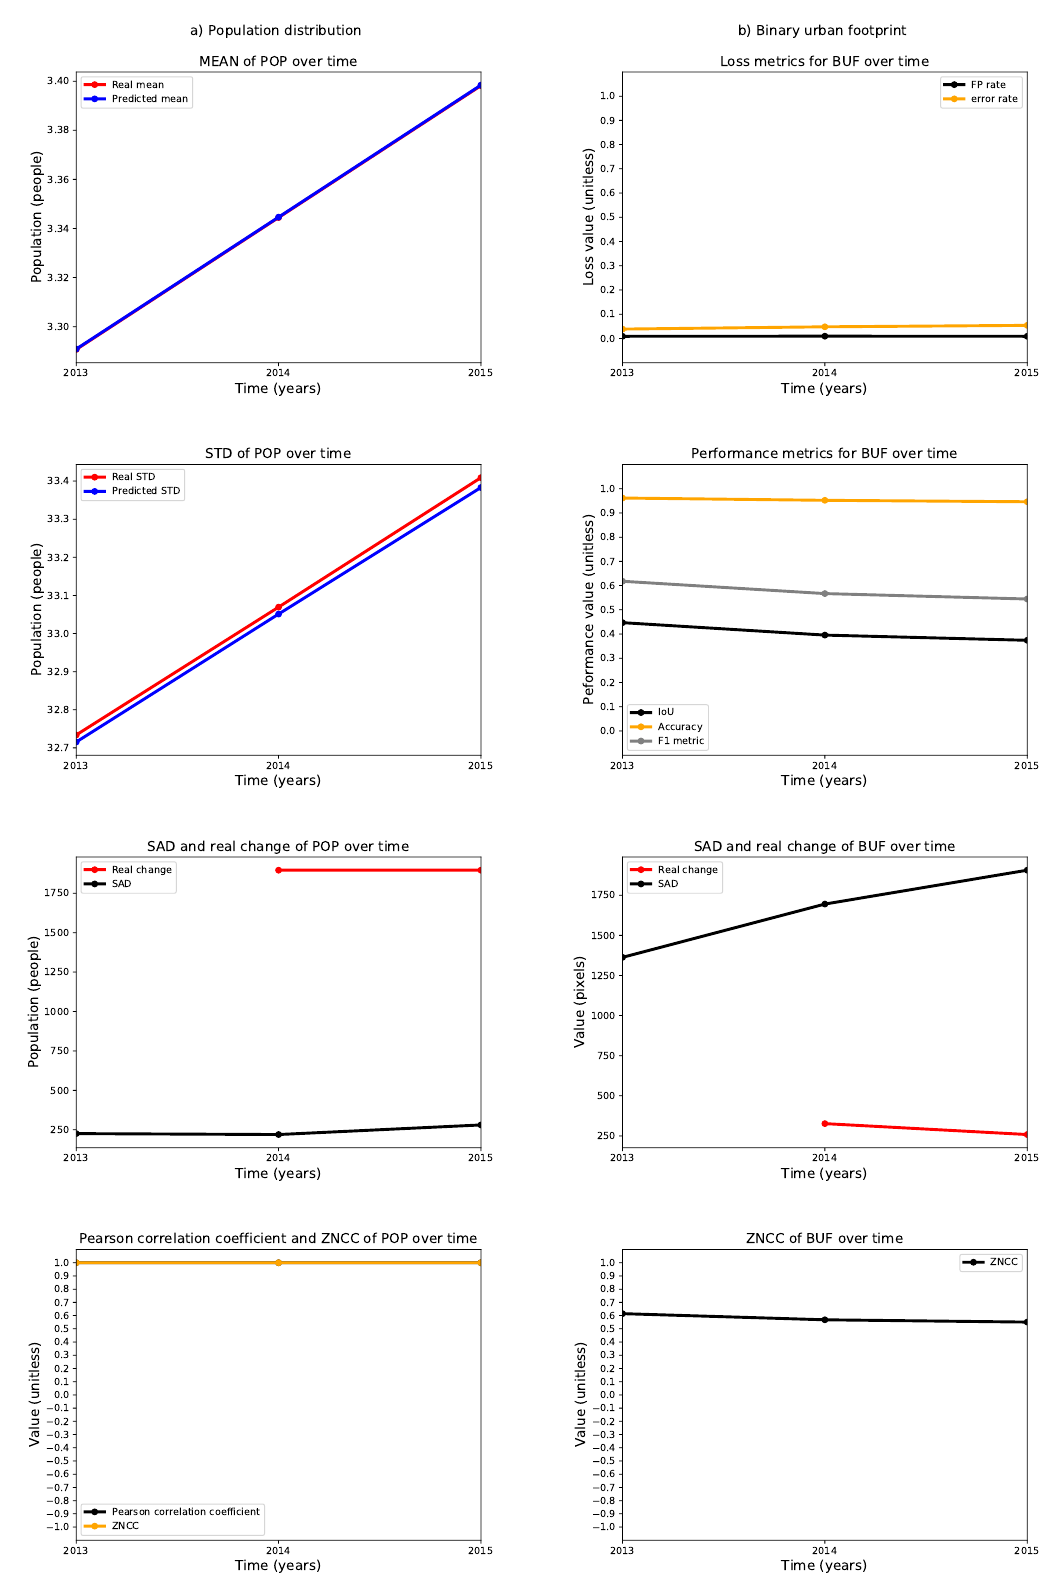
Figure 25. Assessment of the urban predictions in the geographic area of interest masked by the administrative division of Rionegro with the test